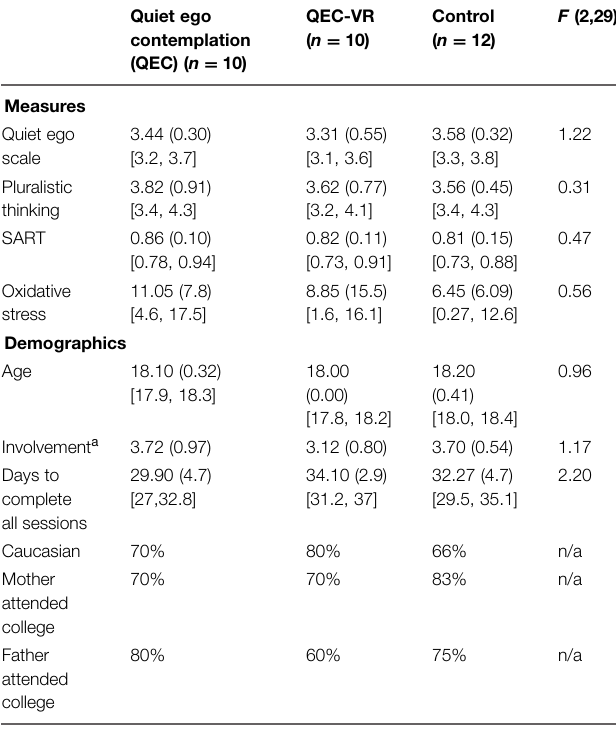
TABLE 1 | Mean (SD) scores for each group on baseline and demographic measures.